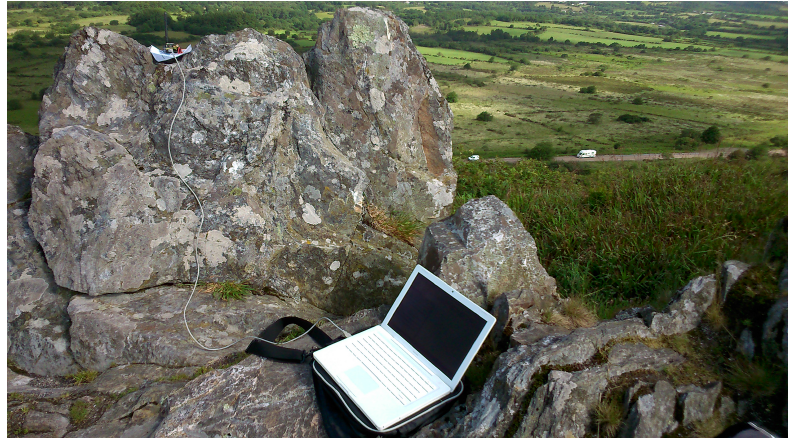
Figure A5. A base station is equipped with a LoRa board (emitter) and a MacBook. This base station was deployed on the top of the Roc’h Trevezel mountain, France. The receiver is another LoRa board mounted on a car moving around.